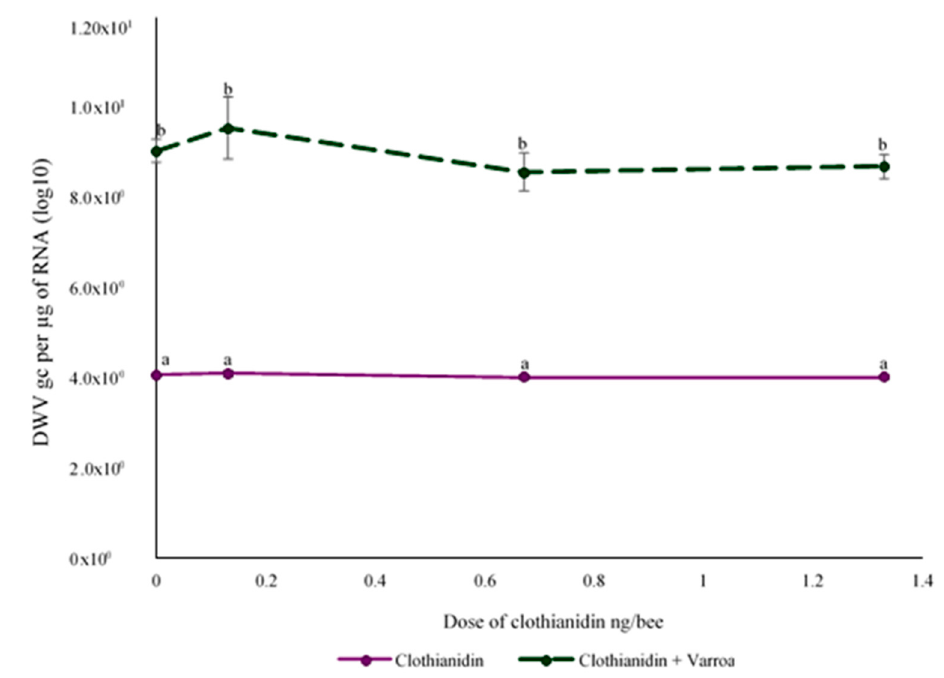
Figure 1. Mean deformed wing virus (DWV) genome copies (GCs) per µg of RNA (± S.E.) of emerged bees that were exposed to clothianidin and/or V. destructor during the larval stage. Different letters above the bars indicate significant differences based on a two-way ANOVA and Tukey’s HSD tests. Log10-transformed data are